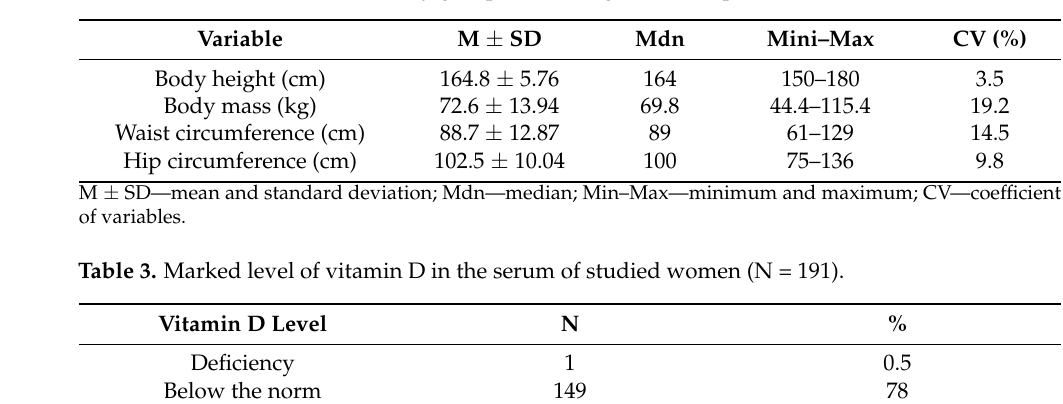
Table 2. Characteristics of the study group concerning the anthropometric measurements.